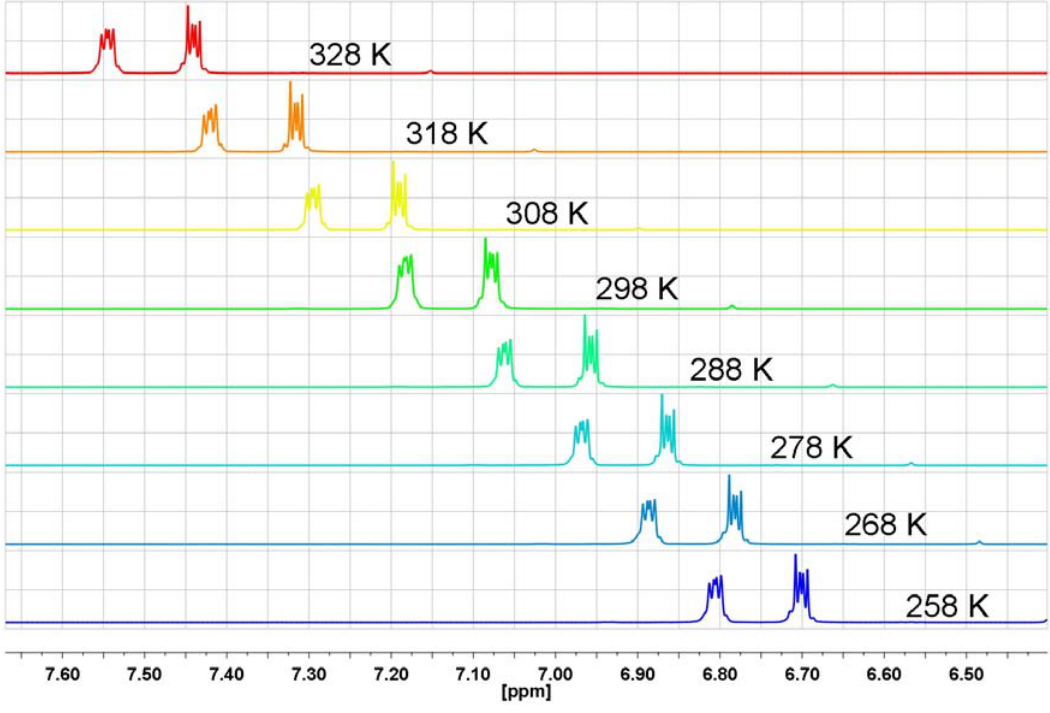
OD for indane at 3